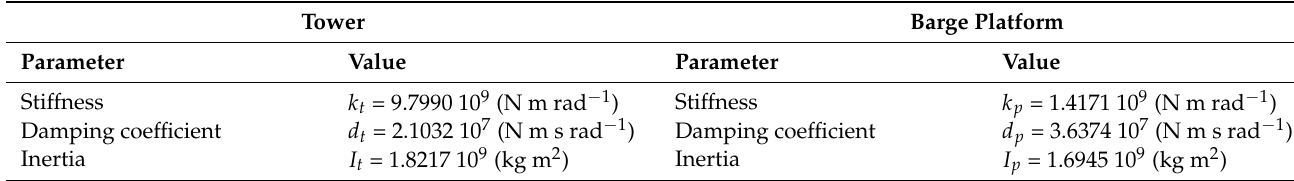
Table 2. Structural parameters of the FOWT